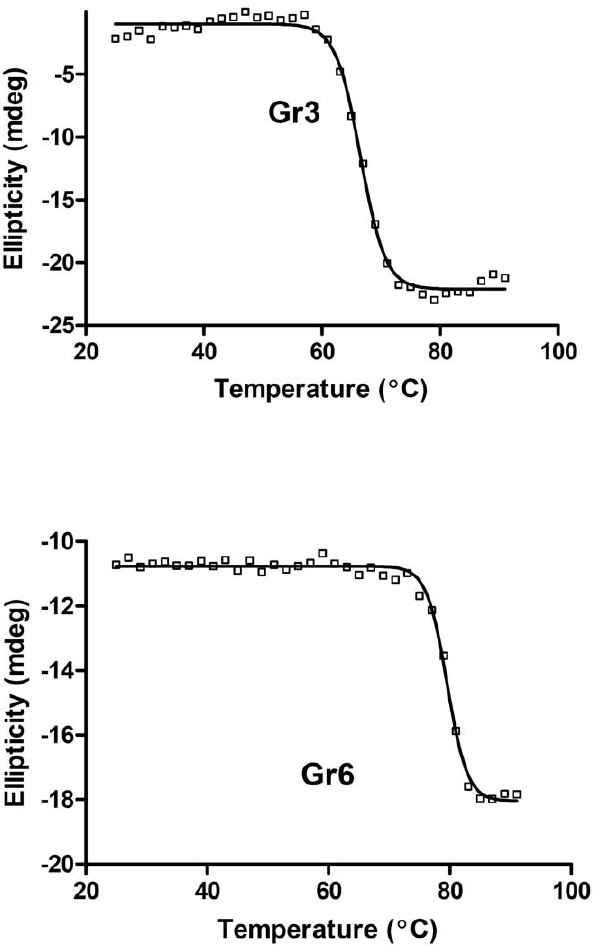
Figure 2. Melting temperature (T m ) measurements of Gr3 and Gr6 by CD spectroscopy. Melting temperature (T m ) measurements of Gr3 and Gr6 by CD spectroscopy. The CD values measured at 217 nm are plotted against temperature ranging from 25 u C to 91 u C. The solid line shows the fitted values using GraphPad Prism software (GraphPad Software Inc., La Jolla,